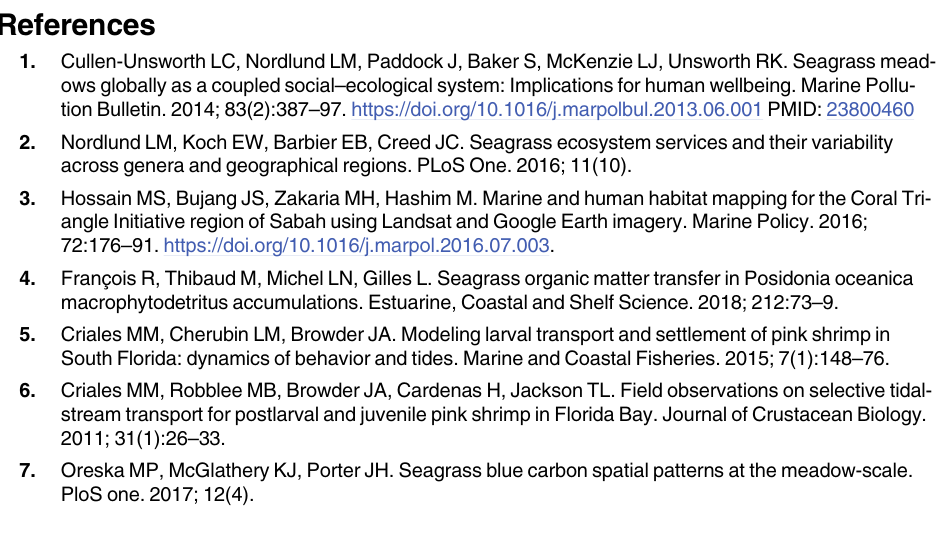
S12 Fig. Receiver operating characteristic curves (ROC) was built and the area under the curve (AUC) for Model F. Mean training AUC value is 0.99 were indicated as excellent dis- criminative ability.